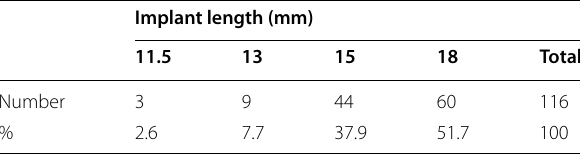
Table 1 The number and percentage of virtually planned implants with different lengths in 116 samples